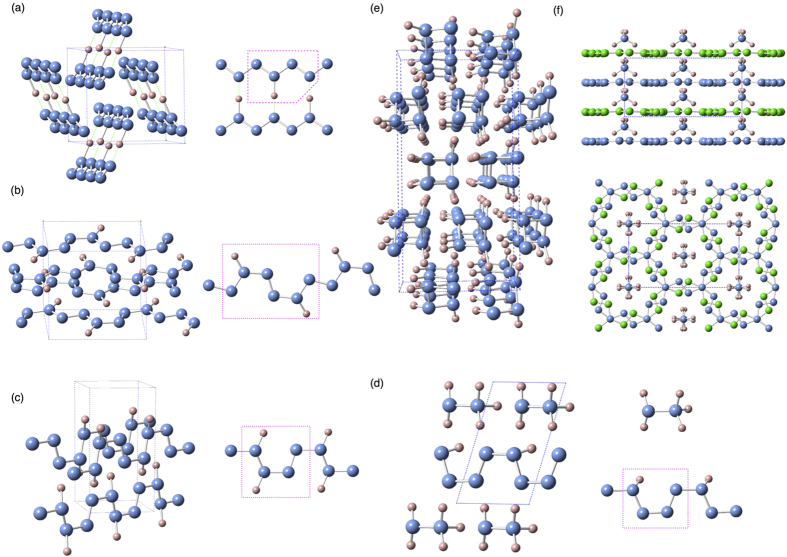
The proposed structures of N4H, N3H, and N2H and NH, N9H4.The small pink spheres indicate hydrogen atoms and the blue large spheres are nitrogen atoms. (a) Cmc21-N4H structure. The structure is composed of one-dimensional zigzag-shaped N-chains. Every two chains are engaged though asymmetric hydrogen bonds. (b) Layered P21/c-N3H structure containing distorted arm-chair-shaped chain. (c) P21/c-N2H structure composed of parallel one-dimensional arm-chair-shaped N2H chains. (d) P1-NH structure. Its structure consists of N2H5+ ions and negatively charged arm-chair-shaped chain layers. It will transform to C2 phase at 180 GPa, due to the symmetrization of the hydrogen bonds between N2H5+ ions and between chains. (e) The Fdd2-NH structure consists of pseudotetragonal spiral chains. (f) Top view and side view of Ccc2-N9H4. The small pink spheres indicate hydrogen atoms and the blue and green large spheres are nitrogen atoms at different layers.